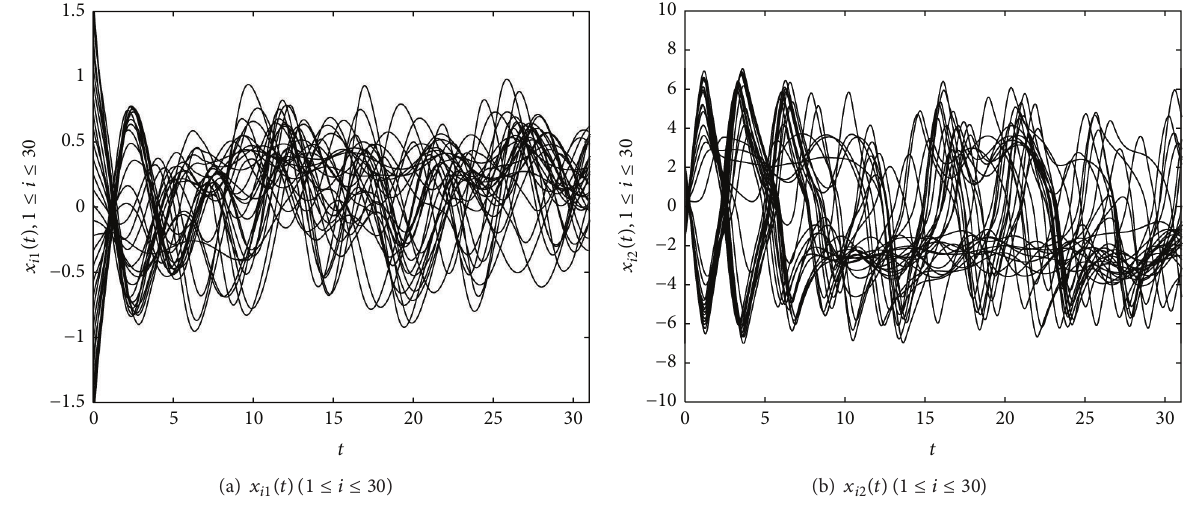
Figure 8: State trajectories of (39) without control: (a) 𝑥 𝑖1 (𝑡)(1 ≤ 𝑖 ≤ 30) , (b) 𝑥 𝑖2 (𝑡)(1 ≤ 𝑖 ≤ 30)